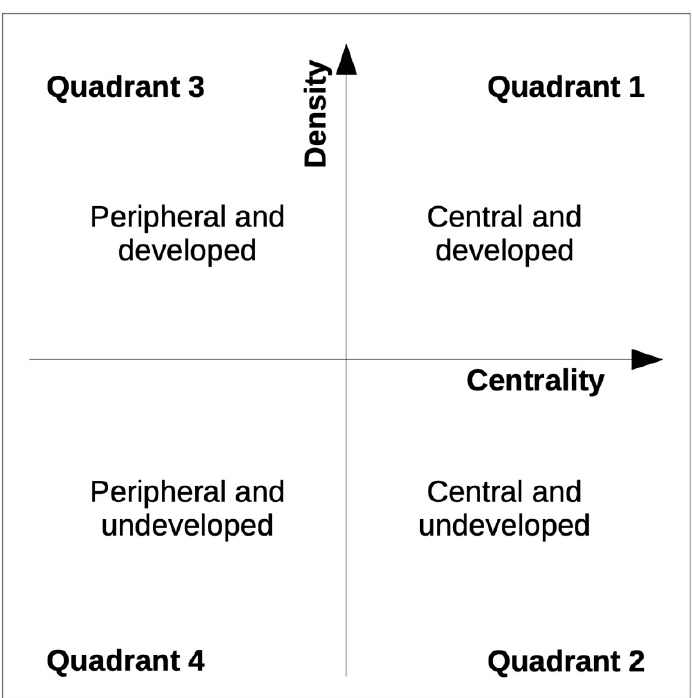
Figure 1. Thematic map strategic diagram with 4 quadrants.